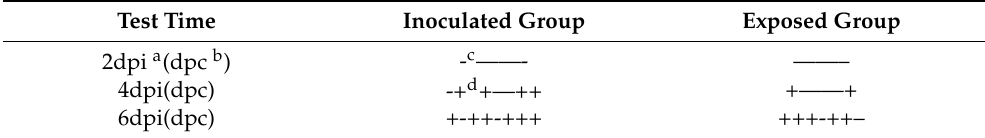
Figure 5. Pathogenicity of DERSV ducks. ( A ) Infected ducks show liver and renal hemorrhage, follicular hemorrhage, and rupture. Congestion of hepatic venules and sinusoid, congestion of renal interstitium, degeneration of renal tubular epithelial cells, and Necrosis of follicular epithelial cells were detectable on the tissue sections accordingly. In addition, viral antigens could be observed in those tissues of infected ducks. ( B ) Virus titer in tissues of livers, kidneys, and ovaries of inoculated and exposed ducks was determined on 9-day-old embryonated duck eggs. The lower limit of virus detection was 0.5log10 EID50 per gram tissue. Table 3. Virus isolation and detection from